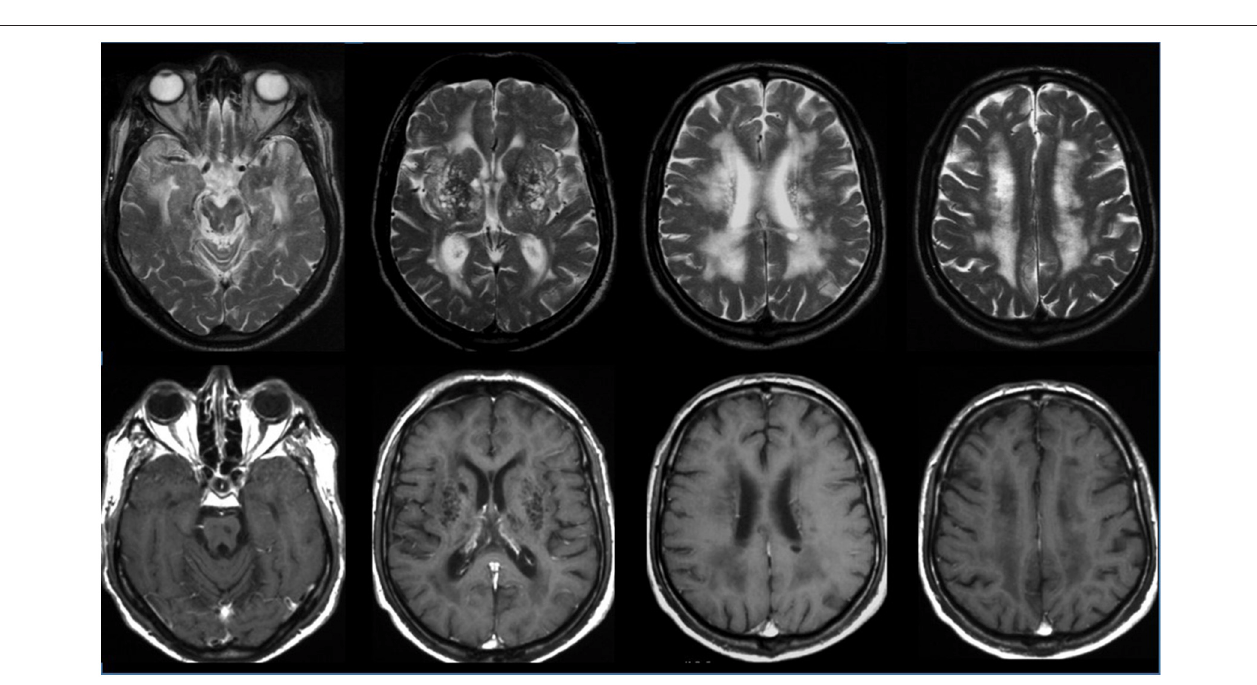
Frontiers in Endocrinology |